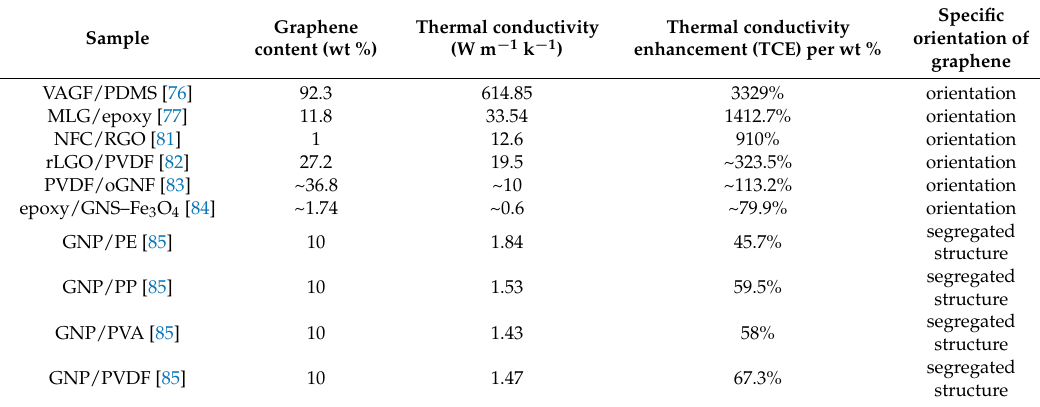
Figure 5. TCE wt % of composites in Table 2. Table 2. Thermal conductivity of polymer composites filled with graphene and graphene-related materials with a specific orientation.